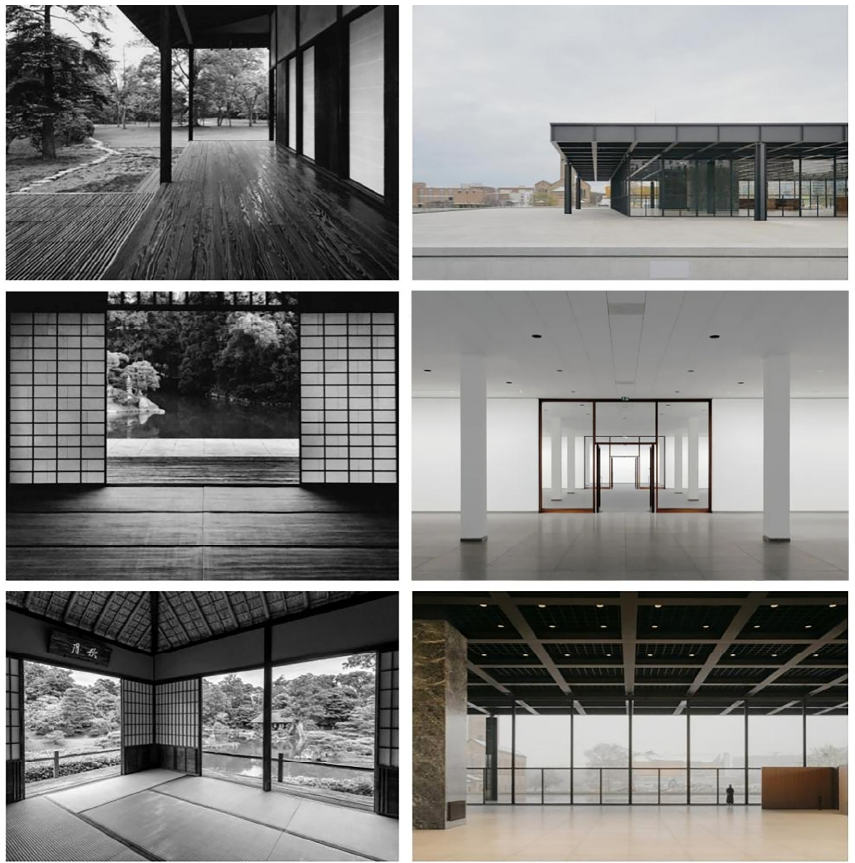
Figure 11. Comparison of Katsura Imperial Villa and Contemporary Architecture (New National Library) (author’s